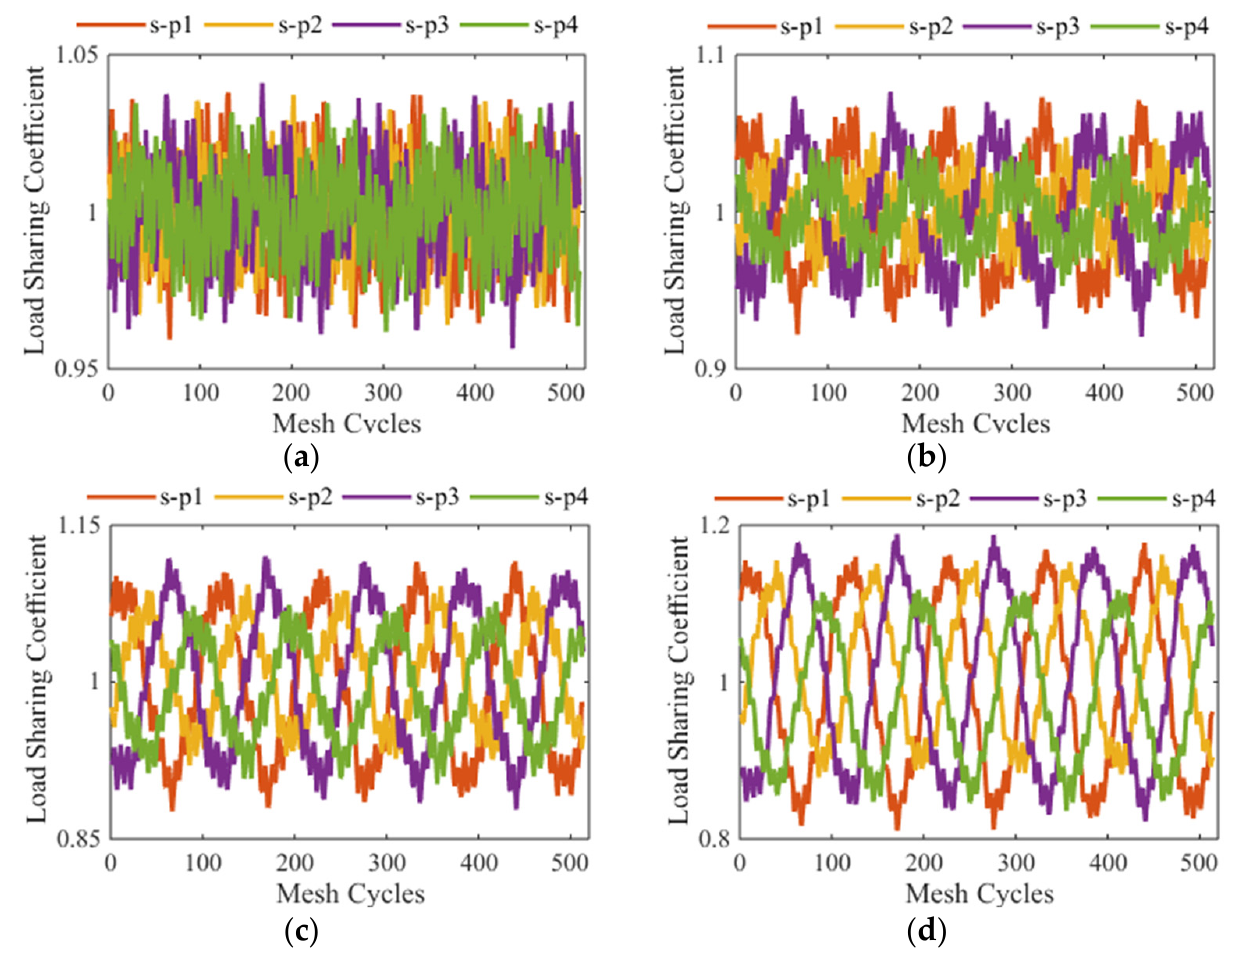
Figure 15. The LSC varies with the number of meshing frequency cycles under different LAV. ( a ) The aircraft is static; ( b ) LAV = 3rad/s, LR = 10 m; ( c ) LAV = 6 rad/s, LR = 10 m; ( d ) LAV = 9 rad/s, LR = 10 m.